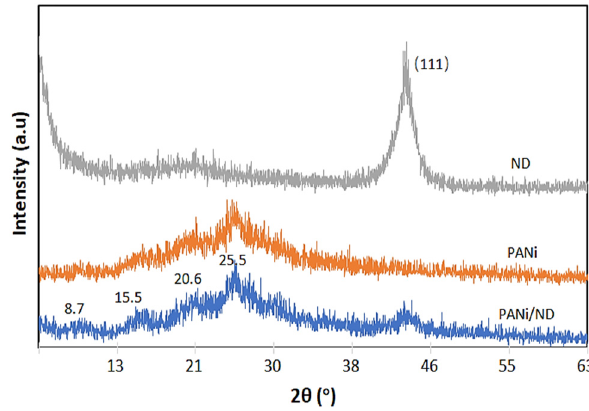
Figure 4: The XRD patterns of ND and PANi and PANi/ND samples.